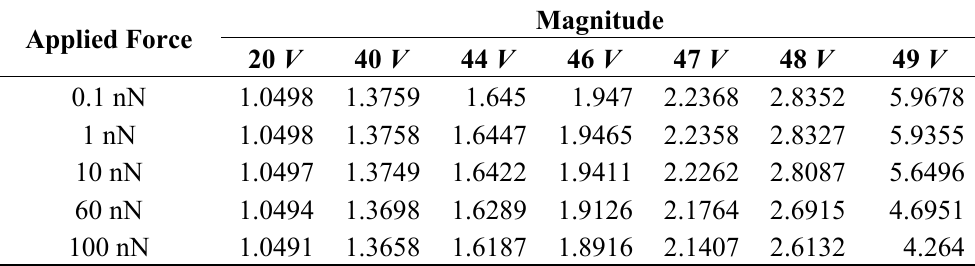
Table 3. Ampli fi cation factor for various applied voltage.